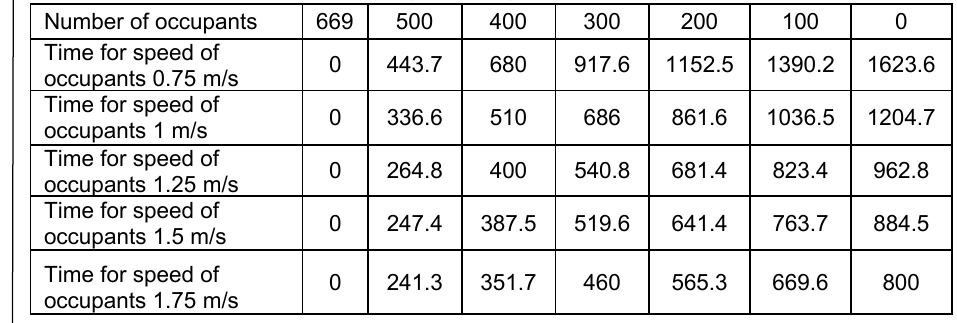
четврти улази  излази блокирани , и за брзине станара : 0,75 m/s, 1 m/s, 1,25 m/s,